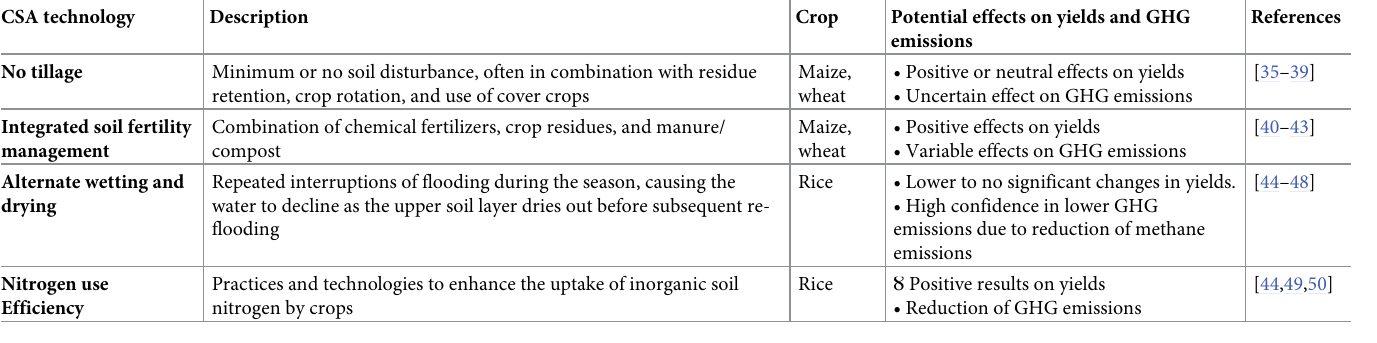
Table 1. CSA technologies considered in this